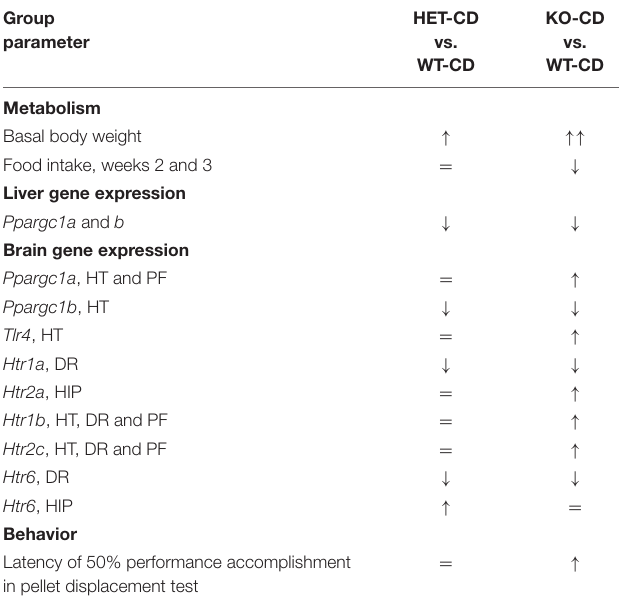
TABLE 5 | Effects of Western diet in groups with different Sert expression. Group parameter